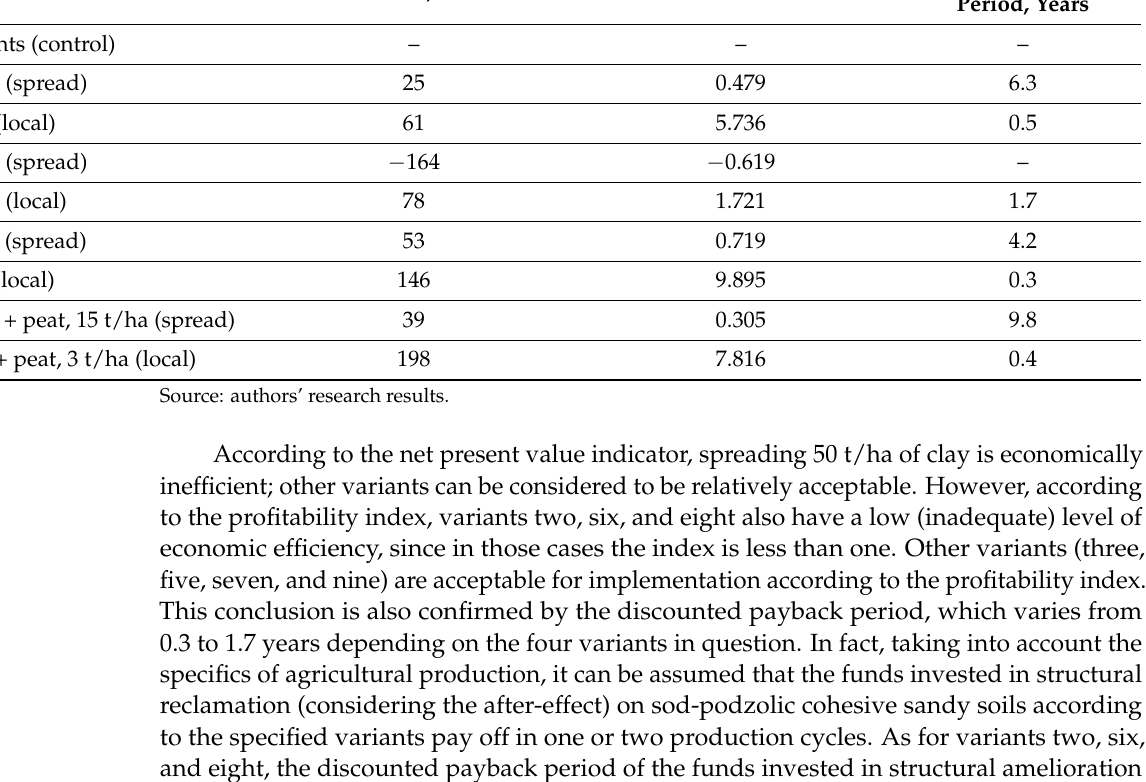
Discounted Payback Period,